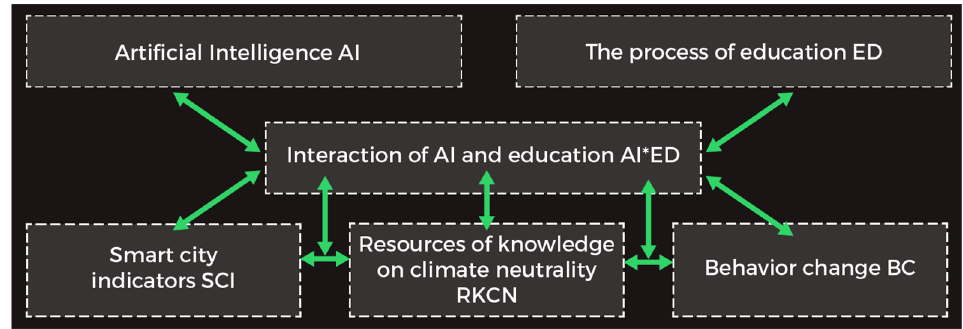
Figure 1. Research idea. Authors’ own elaboration.